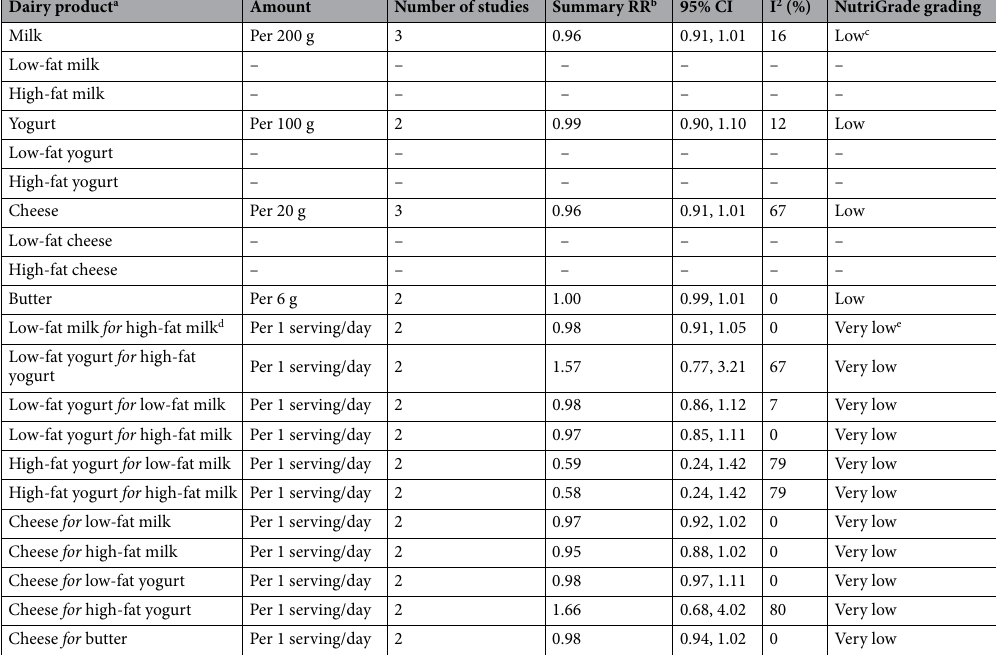
Table 4. Linear dose–response meta-analysis on dairy product subgroups and risk of ischemic stroke, and NutriGrade meta-evidence grading. CI confidence interval; RR risk ratio. a Yogurt defined as yogurt/other soured milk products. b Scoring for effects size was based on summary RR estimates from dose–response meta- analysis. c There is low confidence in the effect estimate, further research will provide important evidence on the confidence and likely change the effect estimate. d Substitutions between dairy product subgroups (per 1 serving/day). For example in the mean of substitution of low-fat milk for high-fat milk; i.e. low-fat milk takes the place of high-fat milk. For milk and yogurt, the serving size was 200 g, for cheese 20 g, and for butter 6 g. e There is very low confidence in the effect estimate; meta-evidence is very limited and